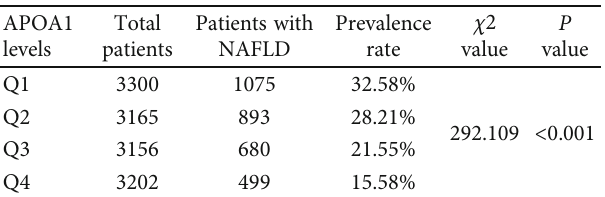
Table 1: The prevalence of NAFLD decreased with the increase of APOA1